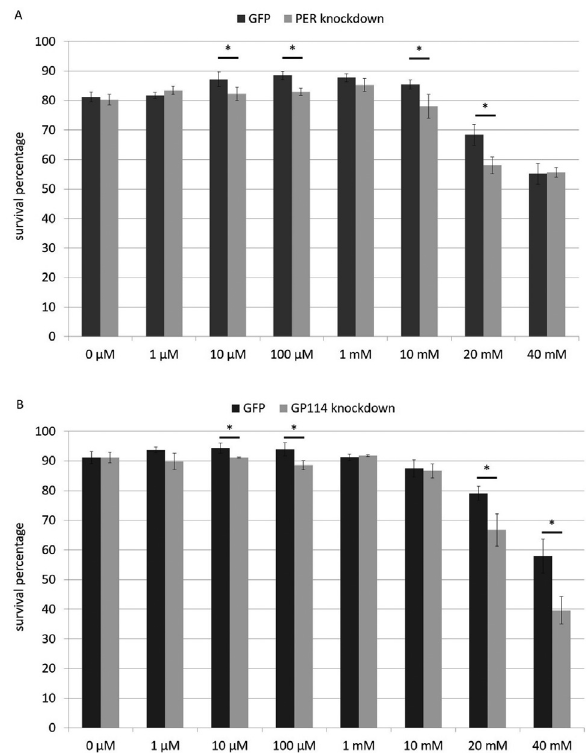
Figure 3 - Molecular confirmation of gene knockdown by semi-quan- titative RT-PCR. Three targets were selected to confirm gene silencing by soaking with dicer substrates, two of which lead to a decrease in survival after desiccation (si46 and si76) and one of which did not (si86). * p<0.05 (Tukey, compared to control